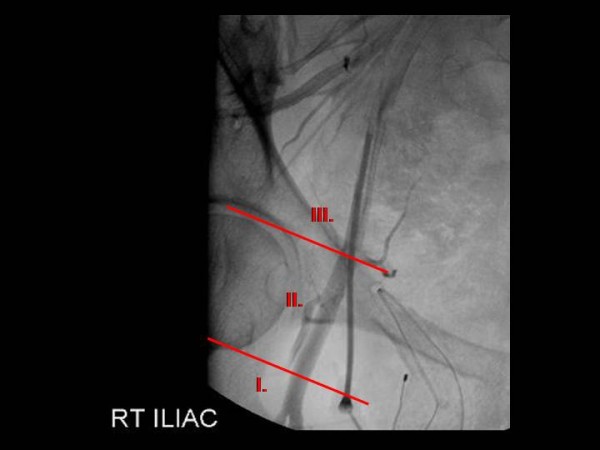
Femoral Angiogram Demonstrating Grading System. Two parallel lines drawn to the top and bottom of femoral head. A grade 1 bifurcation occurs below the femoral head. A grade 2 bifurcation occurs in the region of the femoral head. A grade 3 bifurcation occurs above the femoral head.